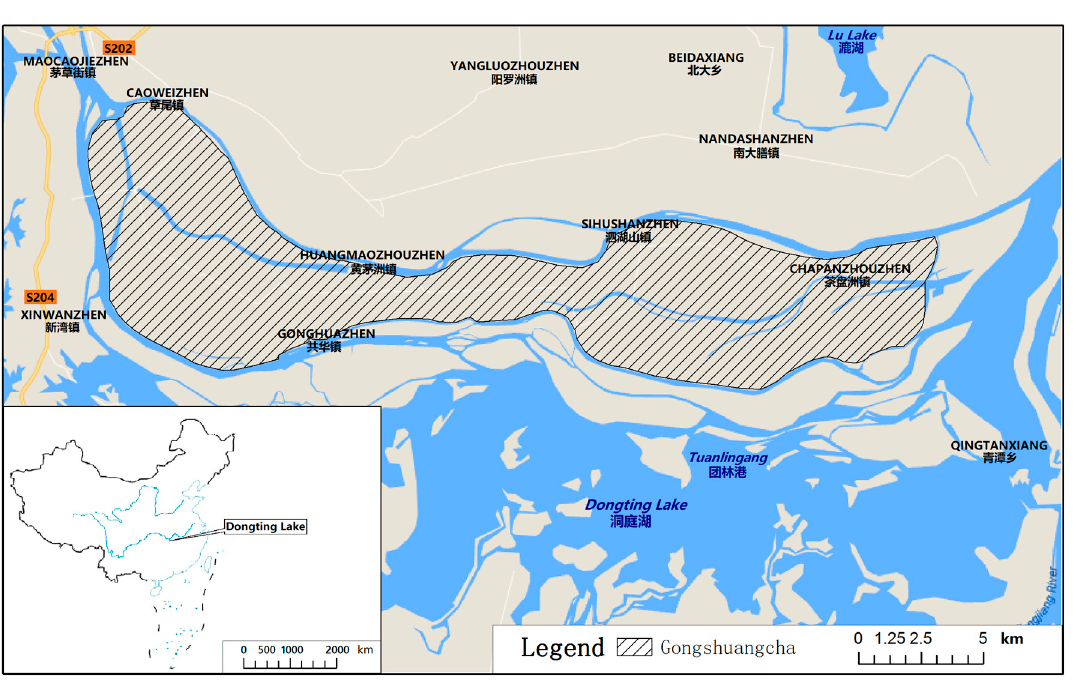
Figure 1. Research area.